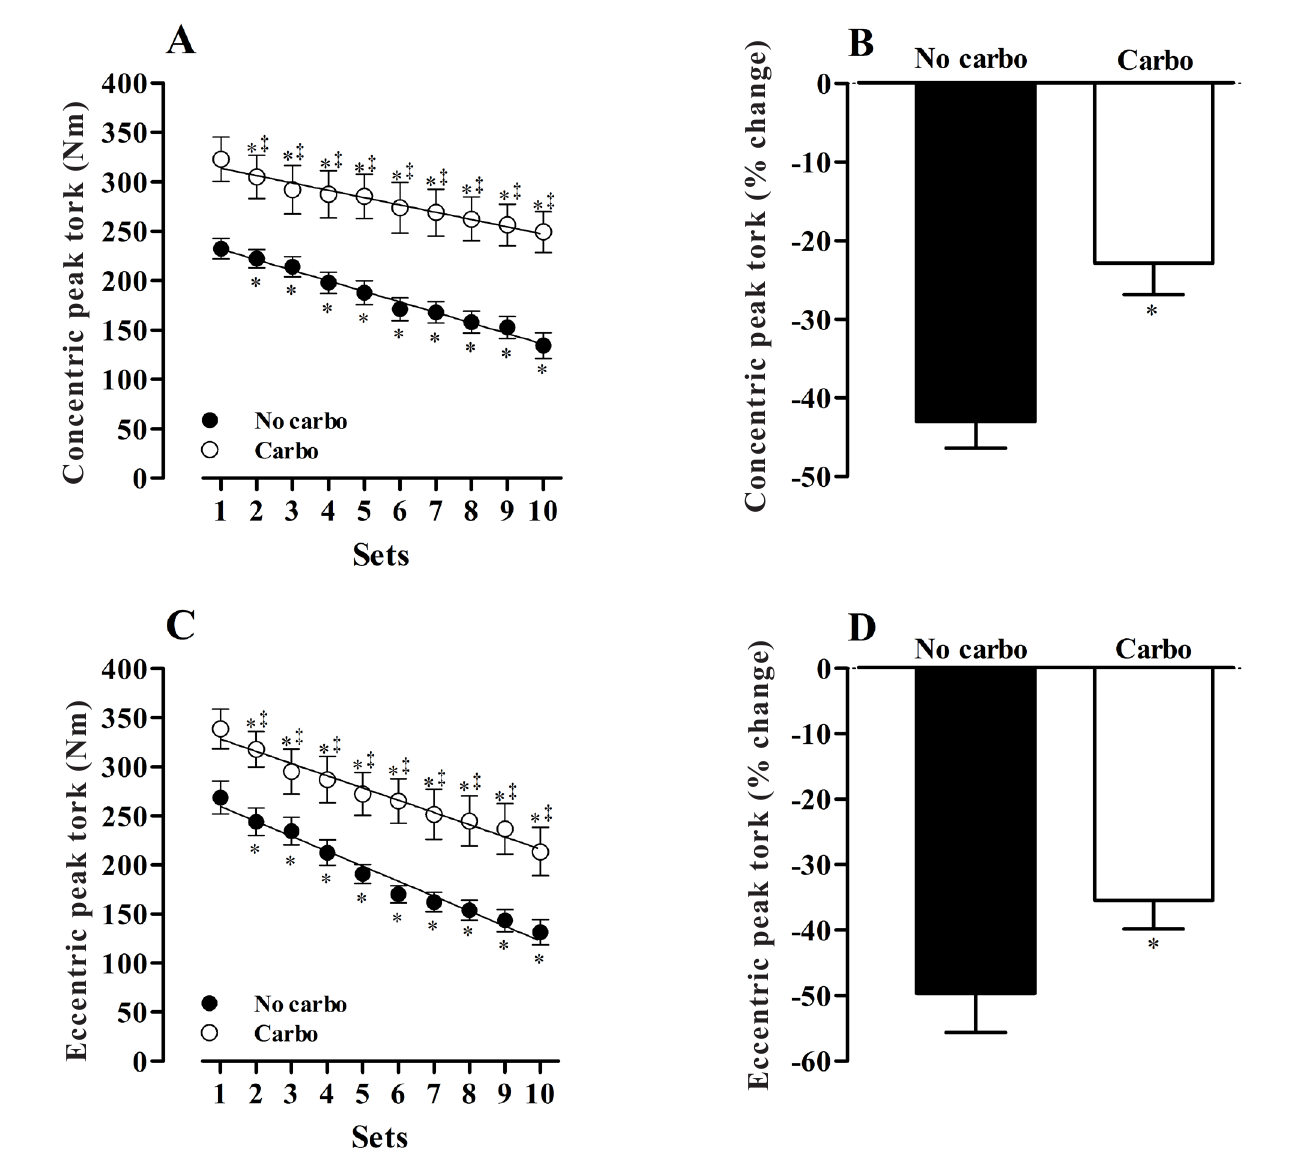
Figure 2. Values expressed in mean ± SD of decline of concentric (panel A) and eccentric peak torque (panel C) during 10 sets of isokinetic mode knee extensions at 120º sec -1 and perceptual changes of concentric (panel B) and eccentric peak torque (panel D) after fatigue induction after placebo or carbohydrate supplementation